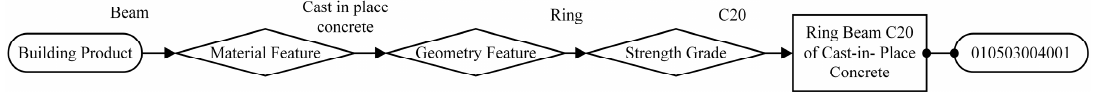
Figure 15. Reasoning process of bill quantity item “Ring beam C20 of cast ‐ in ‐ place concrete” codes as “010503004001”.